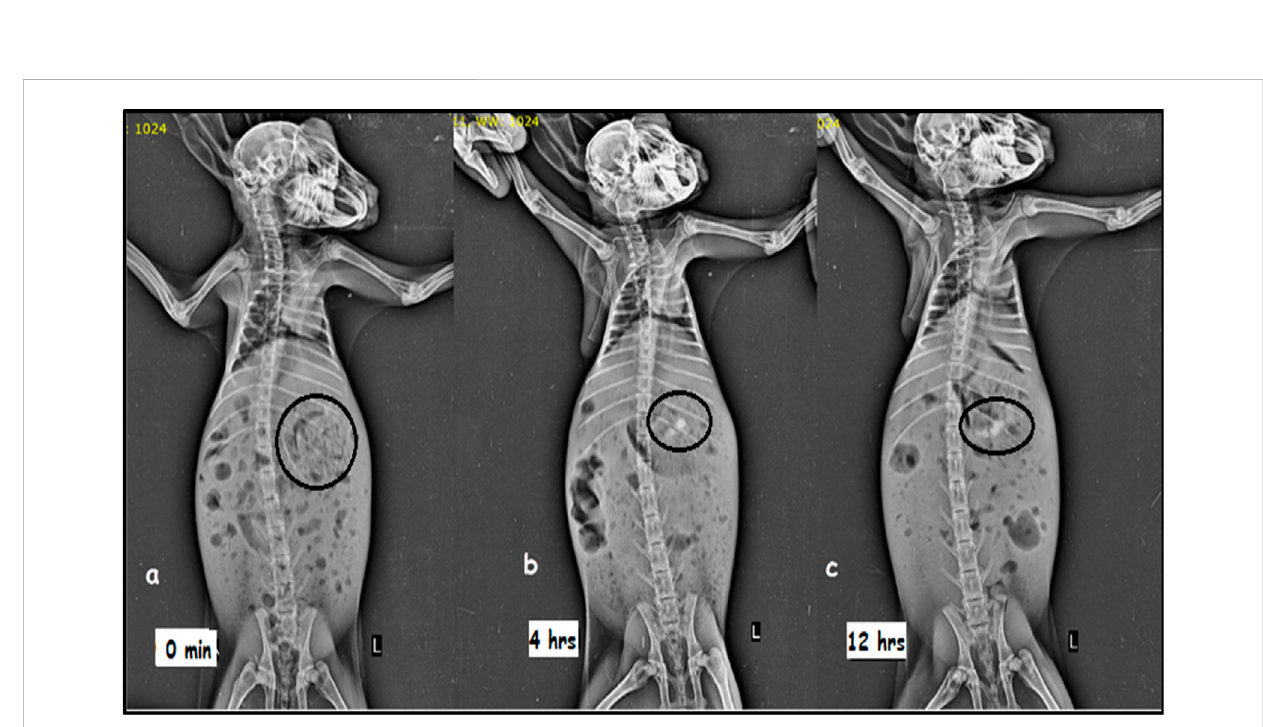
FIGURE 5 X-ray images showing the presence of barium sulfate-loaded fl oating matrix tablet in the rabbit ’ s stomach: (A) 0 min, (B) 4 h, and (C) 12 h.